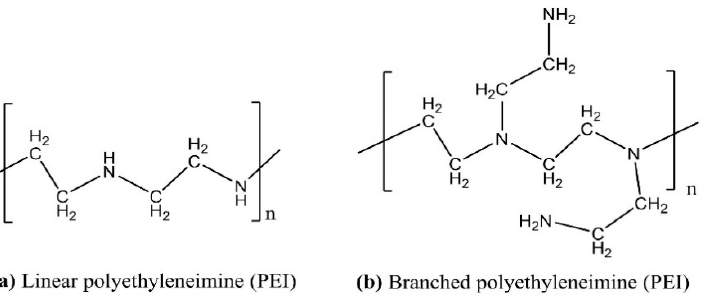
Figure 1. Linear ( a ) and branched ( b ) polyethyleneimine (PEI) used as a surfactant for the pow-